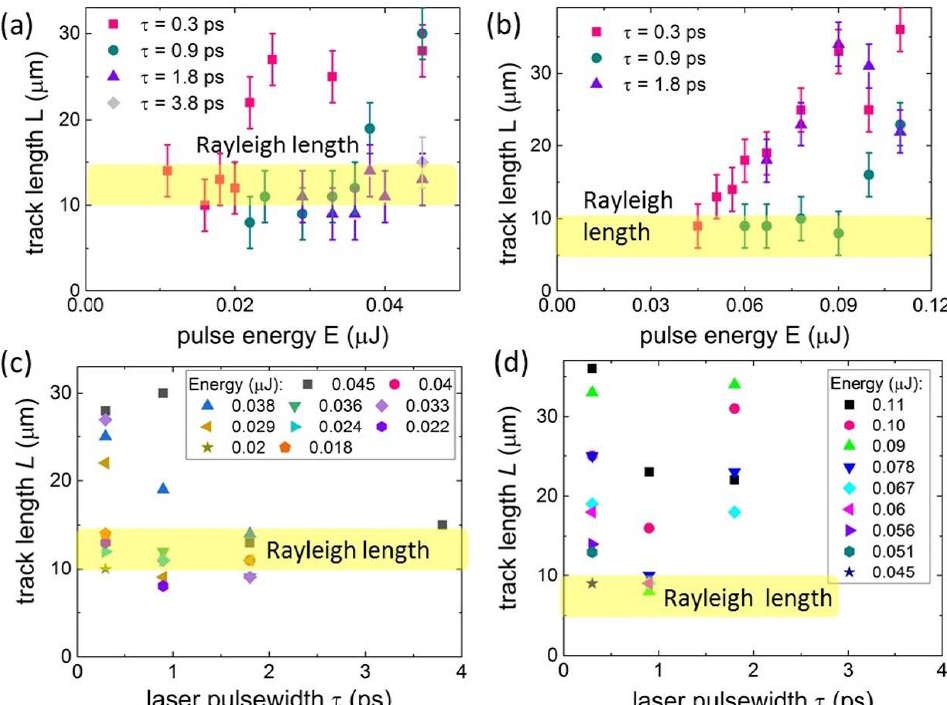
Figure 3. Microtrack length L as a function of pulse energy E at different pulsewidths τ ( a , b ) and of pulsewidth τ at different pulse energies E ( c , d ) at 1030-nm ( a , c ) and 515-nm ( b , d ) wavelengths (for error bars see ( a , b ). The yellow band highlights the Rayleigh length at these laser wavelengths for the 0.25-NA micro-objective in the linear focusing regime.